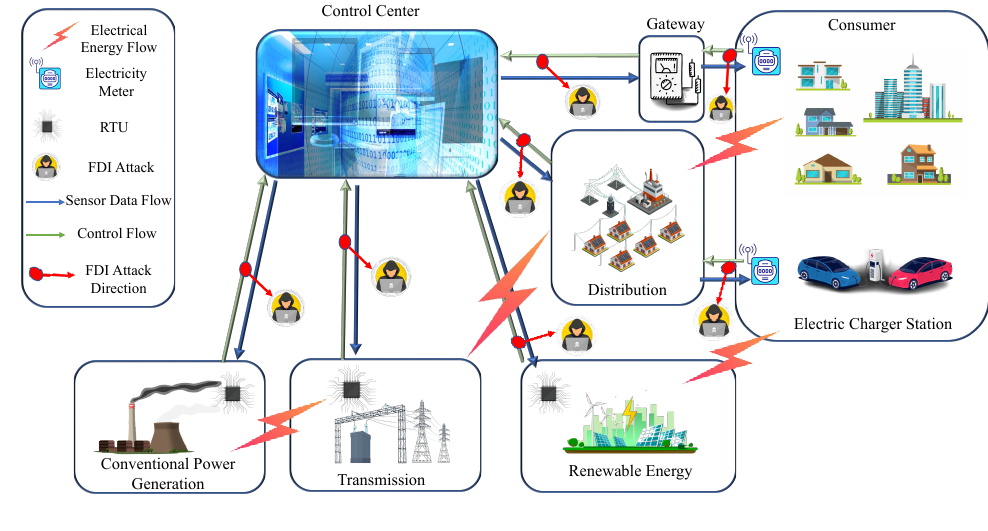
Figure 1. FDI Attack in Smart